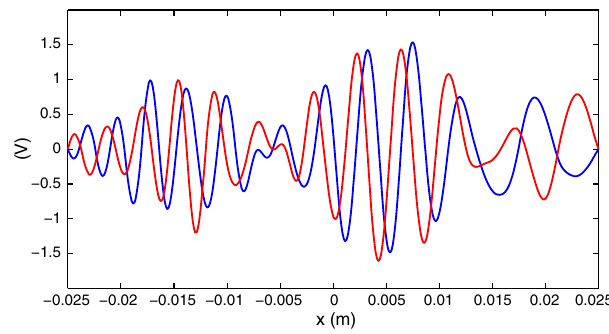
ˆ E k; s; x Þ at y ¼ 0 , at the end of sp ð